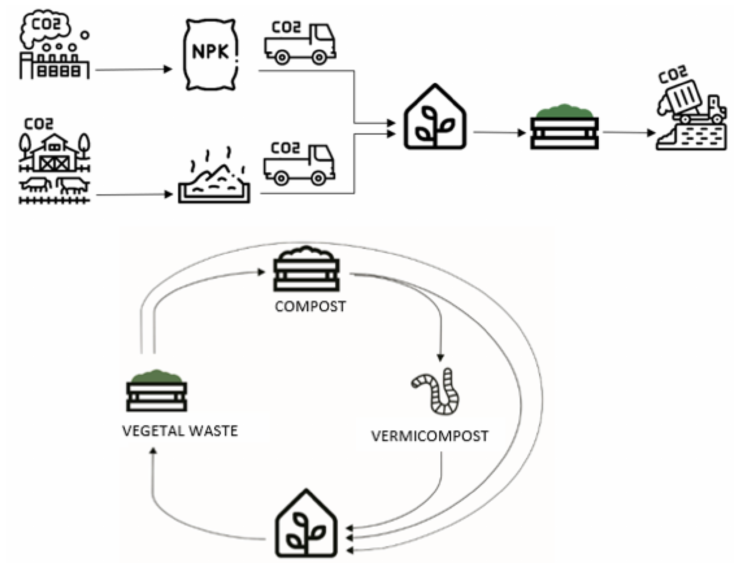
Figure 1. Conventional fertilisation and waste management ( top ) and circular fertilisation and waste management ( bottom